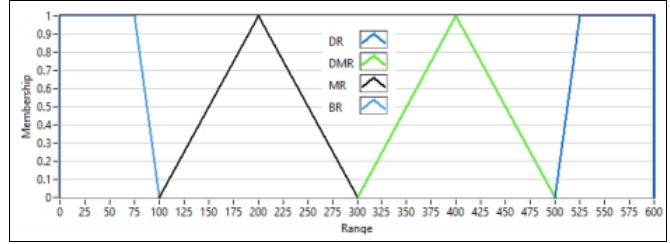
Figure 9: Graph of member functions of Photo r.